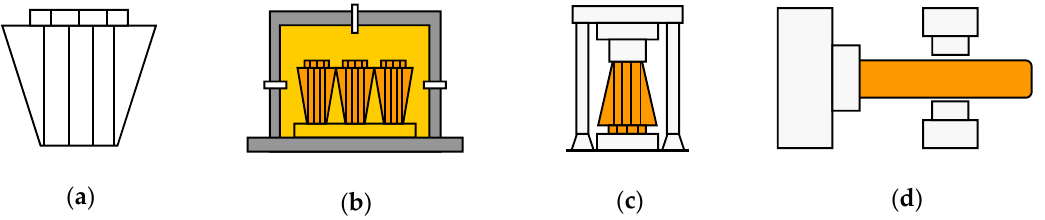
Figure 5. Schematic drawing of the main shaft forging process: ( a ) ingot; ( b ) heating; ( c ) upsetting; ( d )